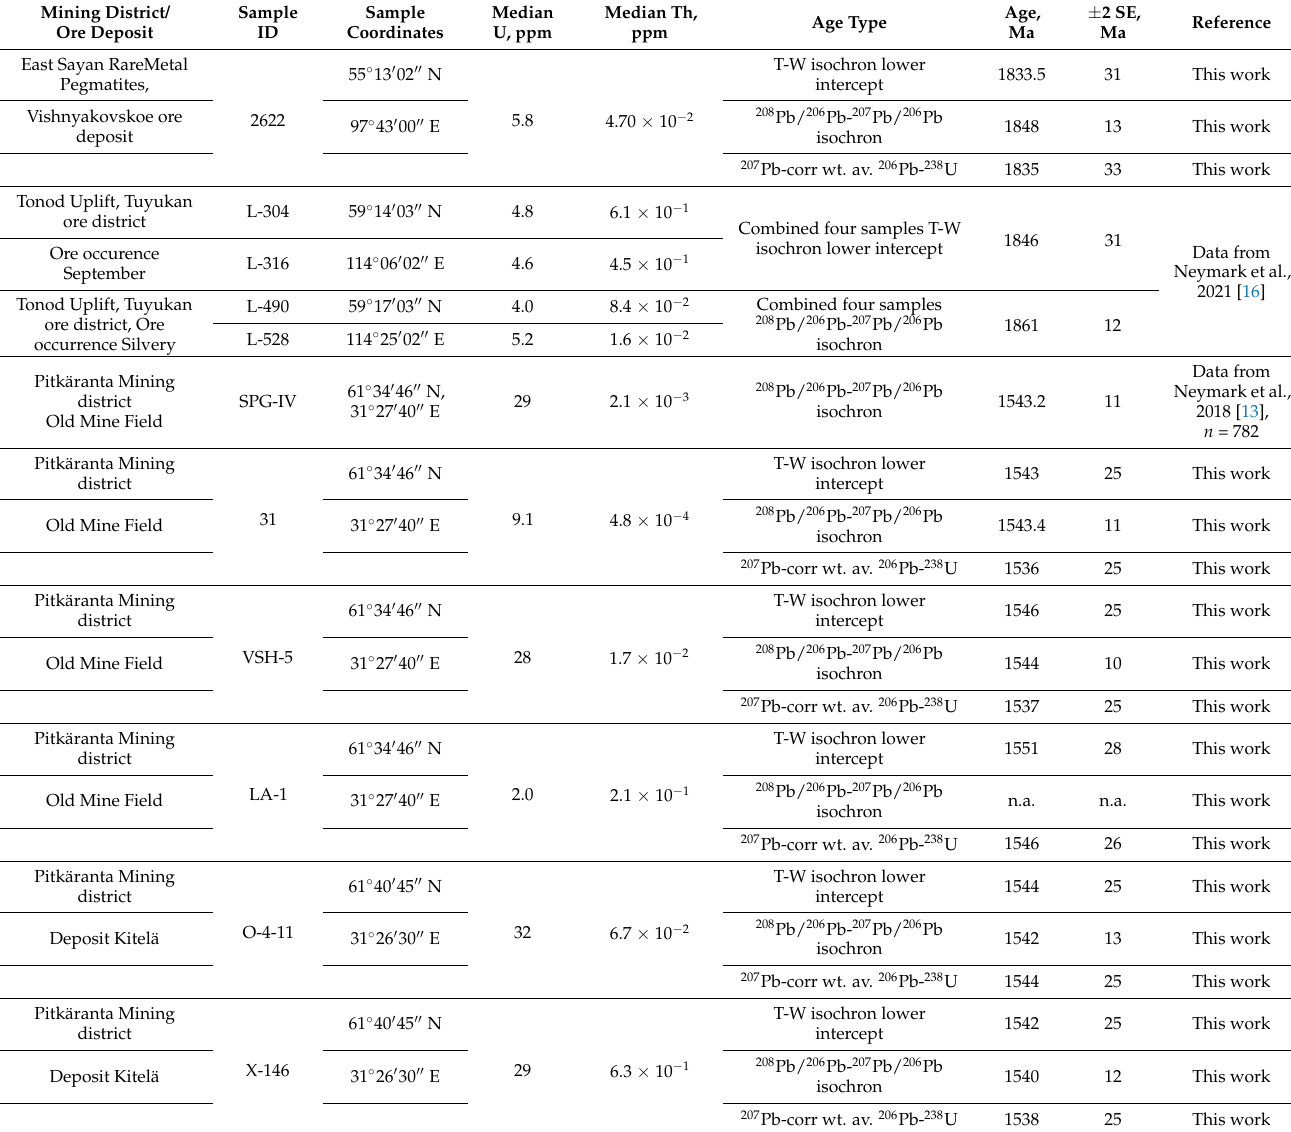
Table 1. Summary of cassiterite U-Pb and Pb-Pb ages determined by in situ LA-ICPMS